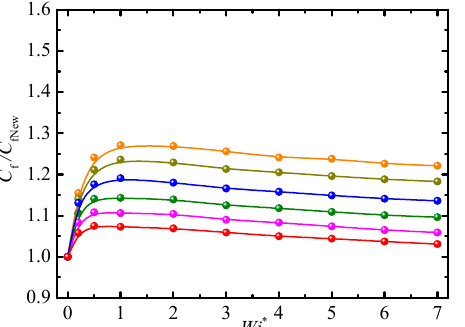
Figure 6. Friction factor vs. modified Weissenberg number for different Reynolds numbers ( β 0 = 0.2, Φ = 1.0%, α = 0.2). ⸺ ● ⸺ : Re = 500; ⸺ ● ⸺ : Re = 100; ⸺ ● ⸺ : Re = 10; ⸺ ● ⸺ : Re = 2.5; ⸺ ● ⸺ : Re = 1; and ⸺ ● ⸺ : Re = 0.5.